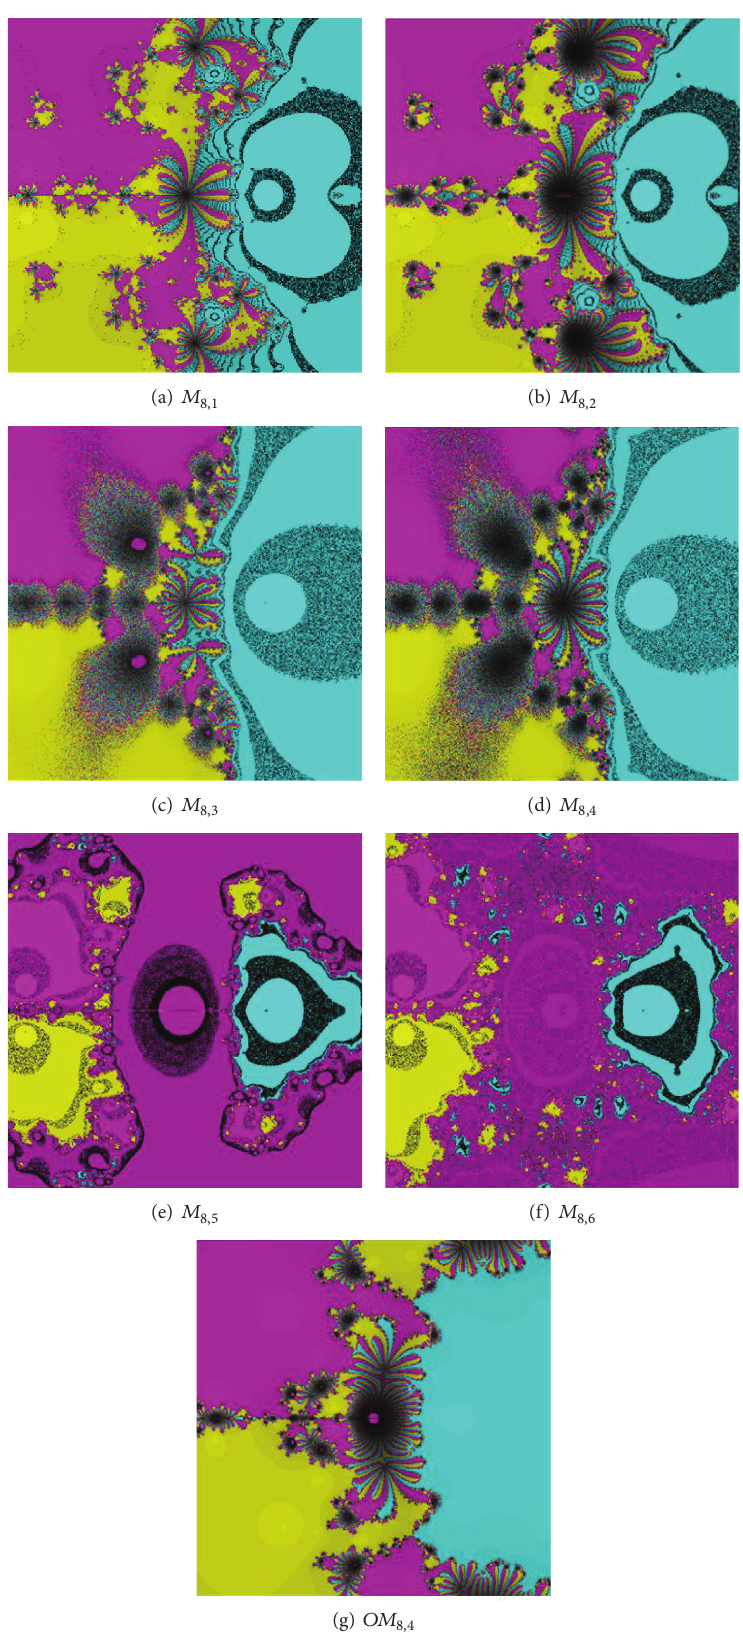
Figure 6: Basins of attraction for polynomial 𝑃 2 (𝑧) = (𝑧 3 + 4𝑧 2 − 10)